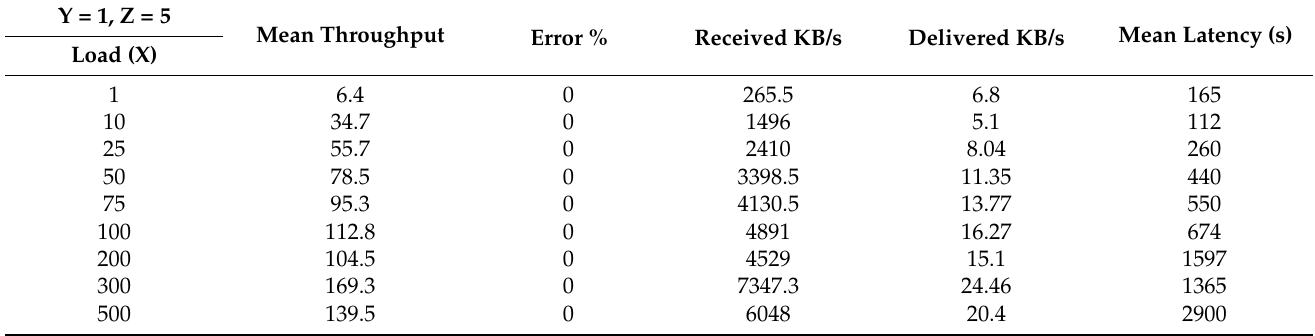
Table 11. Scalability testing results with Y = 1, Z = 5, and variable loads (X).